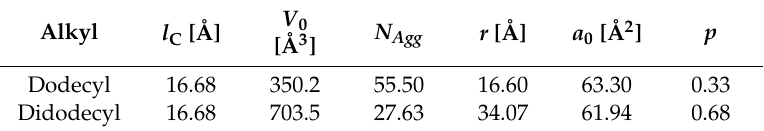
Table 3. Calculated values of l C , V 0 , a 0 , r, N agg and